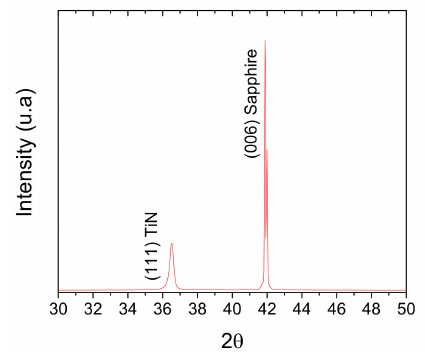
Figure 1. X-ray di ff ractogram of an Nb 2 O 5 / SiO 2 / TiN structure deposited on a sapphire plate.